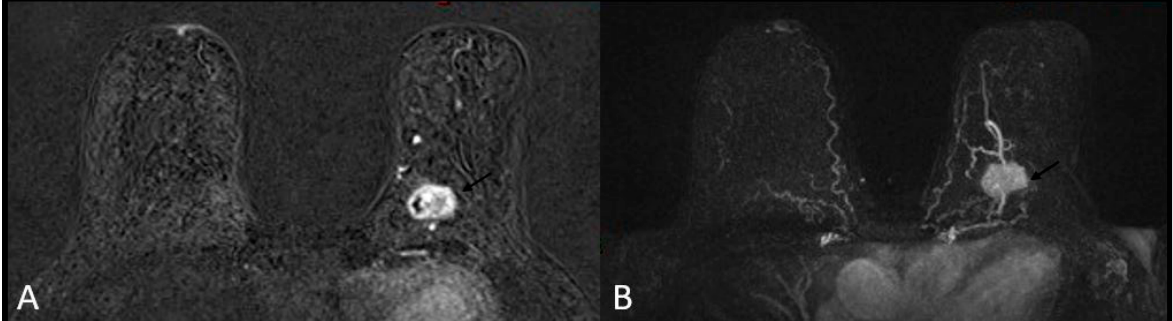
Figure 4. Triple negative breast cancer in a 60-year-old woman—heterogeneous enhancement on subtracted T1-weighted contrast-enhanced image ( A ) and maximum intensity projection (MIP, ( B )).